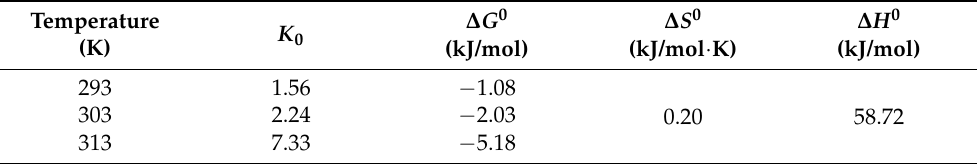
Table 4. Thermodynamic parameters of Co(II) during the adsorption onto